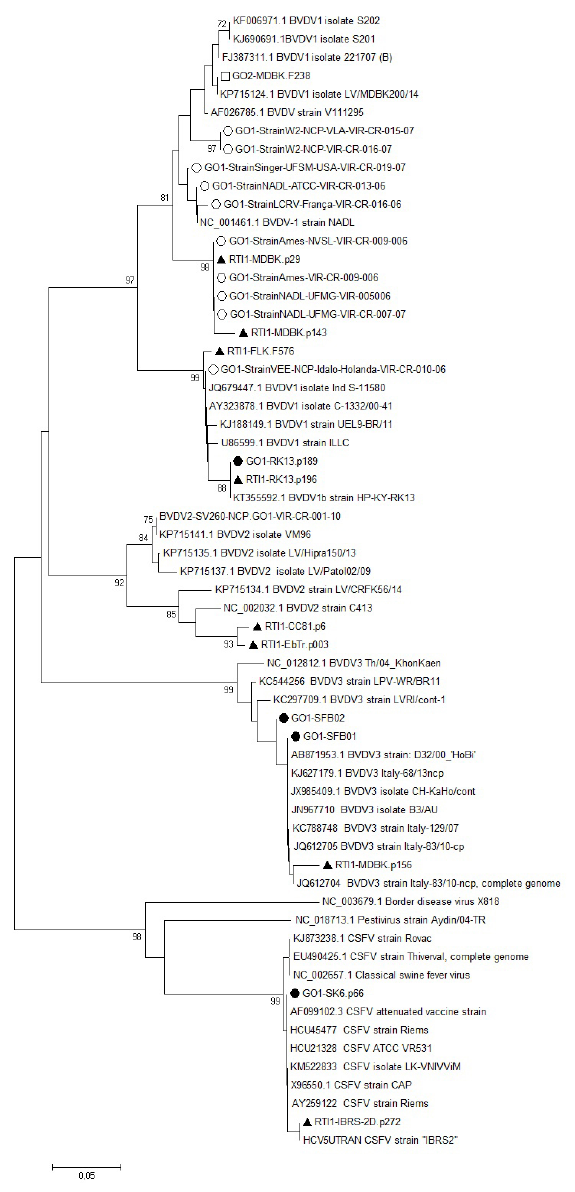
Figure 1. The evolutionary history by the Neighbor- Joining method. The optimal tree with the sum of branch length = 1,24082590 is shown. The percentage of replicate trees in which the associated taxa clustered together in the bootstrap test (500 replicates) is shown next to the branches. The tree is drawn to scale, with branch lengths in the same units as those of the evolutionary distances used to infer the phylogenetic tree. The evolutionary distances were computed using the Kimura 2-parameter method and are in the units of the number of base substitutions per site. The rate variation among sites was modeled with a gamma distribution (shape parameter = 5). The analysis involved 62 nucleotide sequences. Sequences from Pestivirus detected in □ cell lines from GO2 ▲ cell lines from RT1 ● cell lines and CSF from GO1 ○ reference strains form